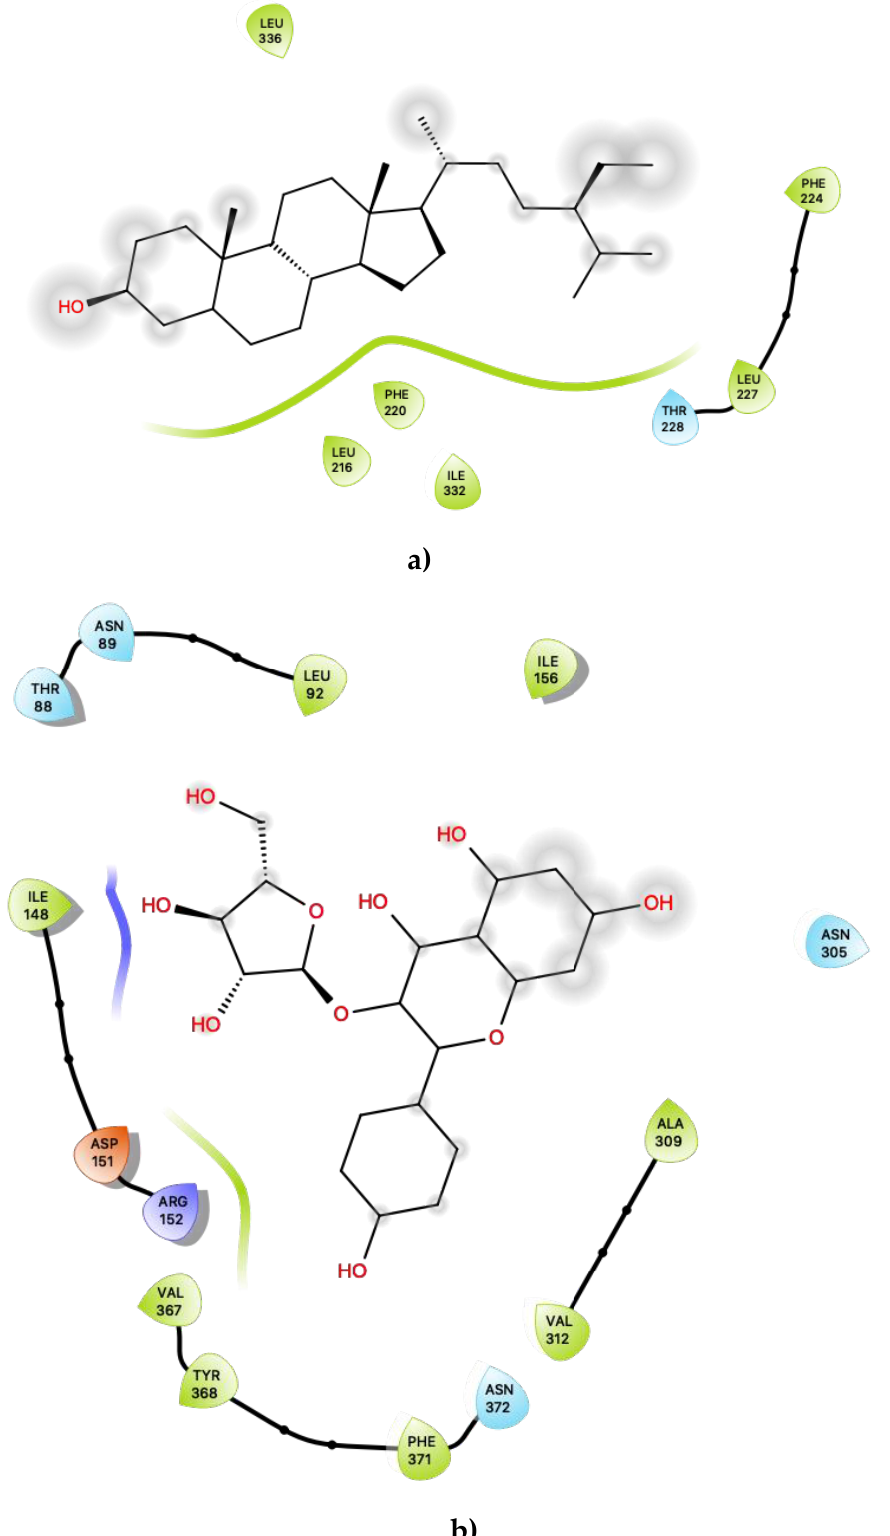
Figure 4. ( a ) Ligand-protein interaction of c32-S1 and ( b ) c33-S1. Grey halos indicate solvent-expose atoms.